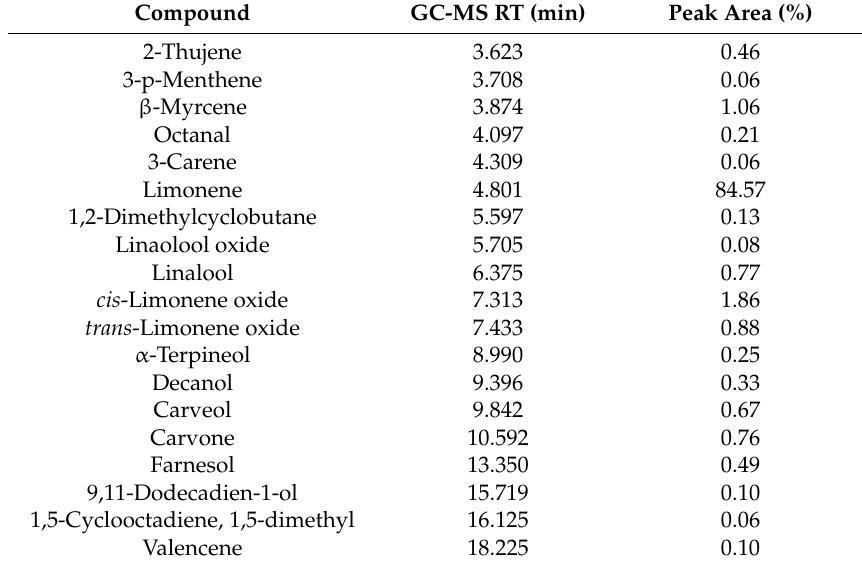
Table 1. Identified compounds of orange oil. GS-MC—gas chromatography mass spectrometer. Compound GC-MS RT